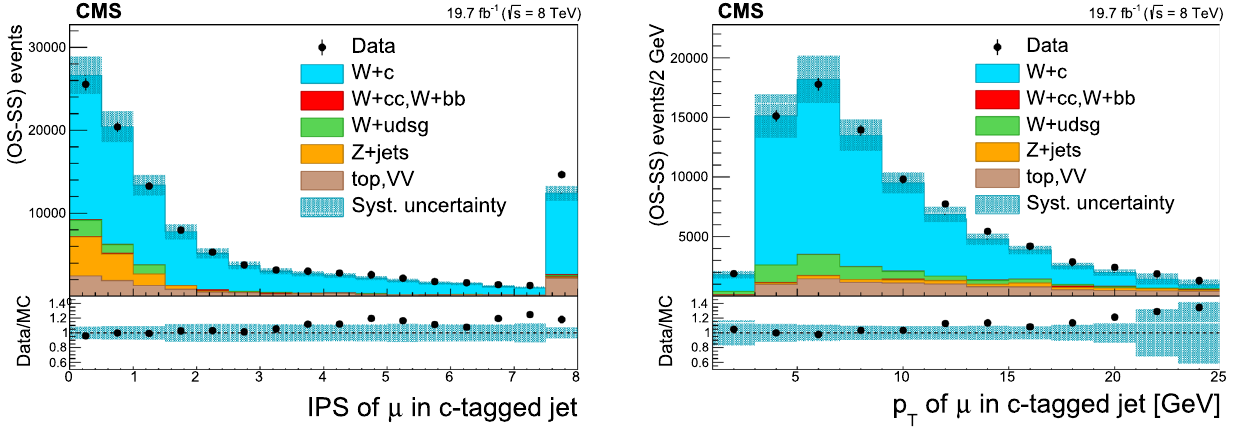
Fig. 2 Distributions after OS–SS subtraction of the impact parameter significance, IPS, (left) and p T (right), of the muon inside the c jet for events in the SL sample, summing up the contributions of the two W boson decay channels. The IPS distribution is shown after all selection requirements except the one on this variable. The last bin of the distri- bution includes all events with IPS > 7 . 5. The p T distribution includes the selection requirement IPS > 1 . 0 for the W → μν channel. The